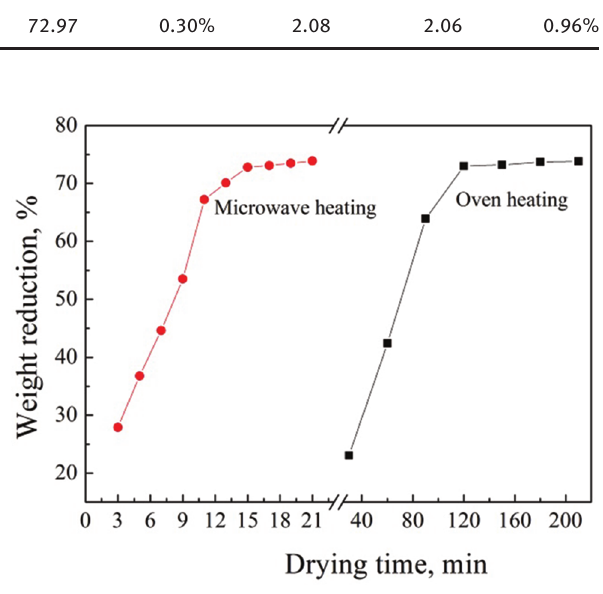
Figure 5: Comparison of effect of drying time on weight reduction using oven and microwave